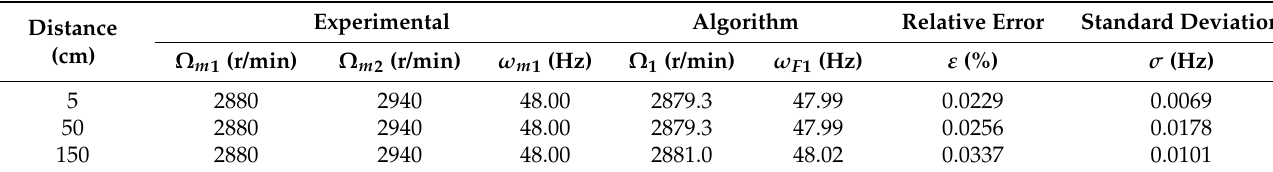
Table 16. No load coupled to the motor shaft: estimation of the frequency, speed and the relative errors for faced motors. Distance